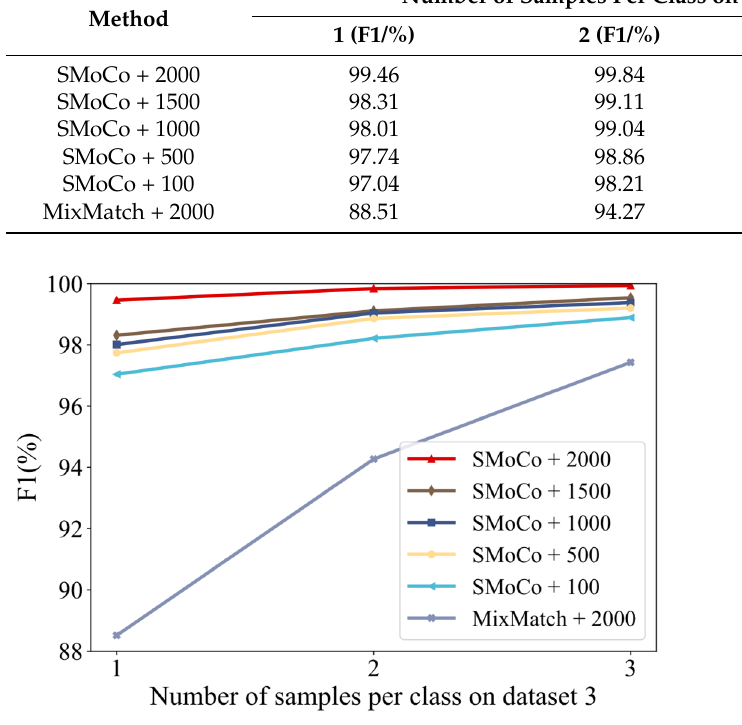
Figure 18. Experimental results of the sensitivity to the size of the data set on dataset 3.